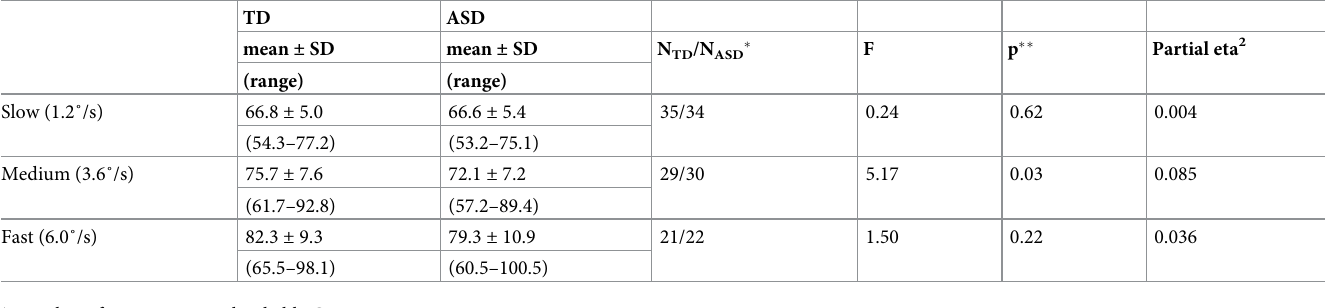
Table 4. Frequency of gamma response (GR) in TD and ASD groups of children and analysis of group differences (ANCOVA results). TD ASD